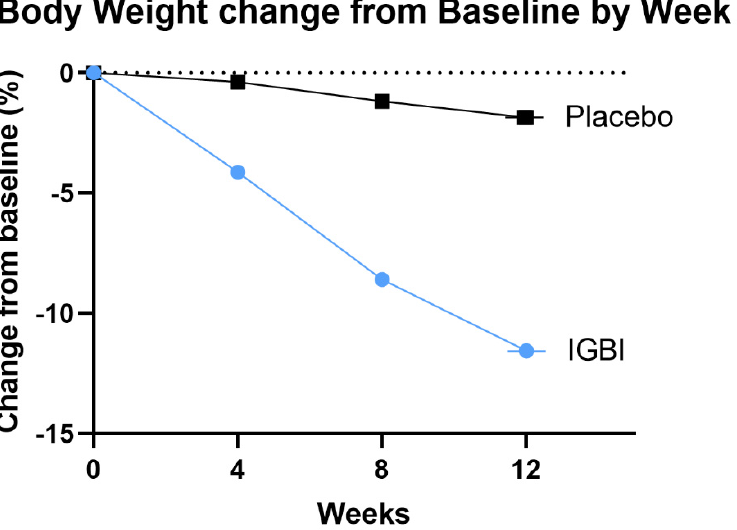
Figure 2. Comparing 12-week body weight change from baseline in the IGBI and placebo groups. IGBI: intragastric botulinum injection.